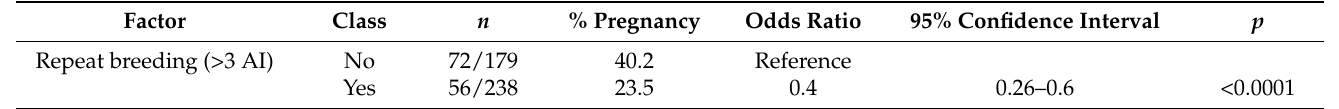
Table 2. Odds ratios of the pregnancy rate variables included in the final logistic regression model ( n =